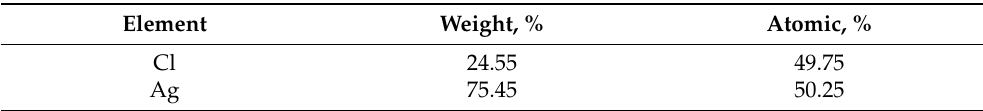
Table 10. Semi-quantitative analysis of the Ag-Cl phase.